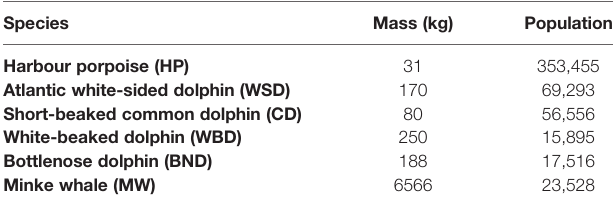
TABLE 1 | JCP population sizes and average mass values